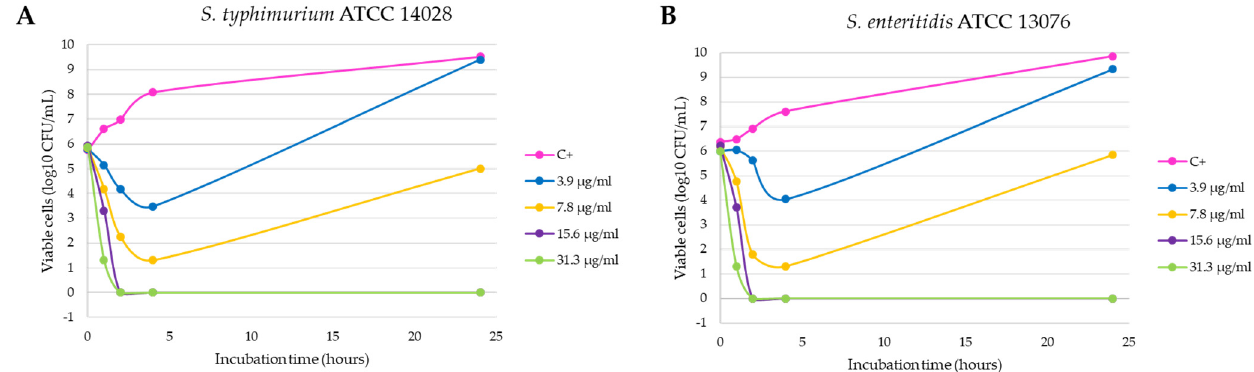
Figure 3. Inhibition curves of product C3-L1 in liquid medium against the Gram-negative strains Salmonella typhimurium ATCC 14028 ( A ) and Salmonella enteritidis ATCC 13076 ( B ).